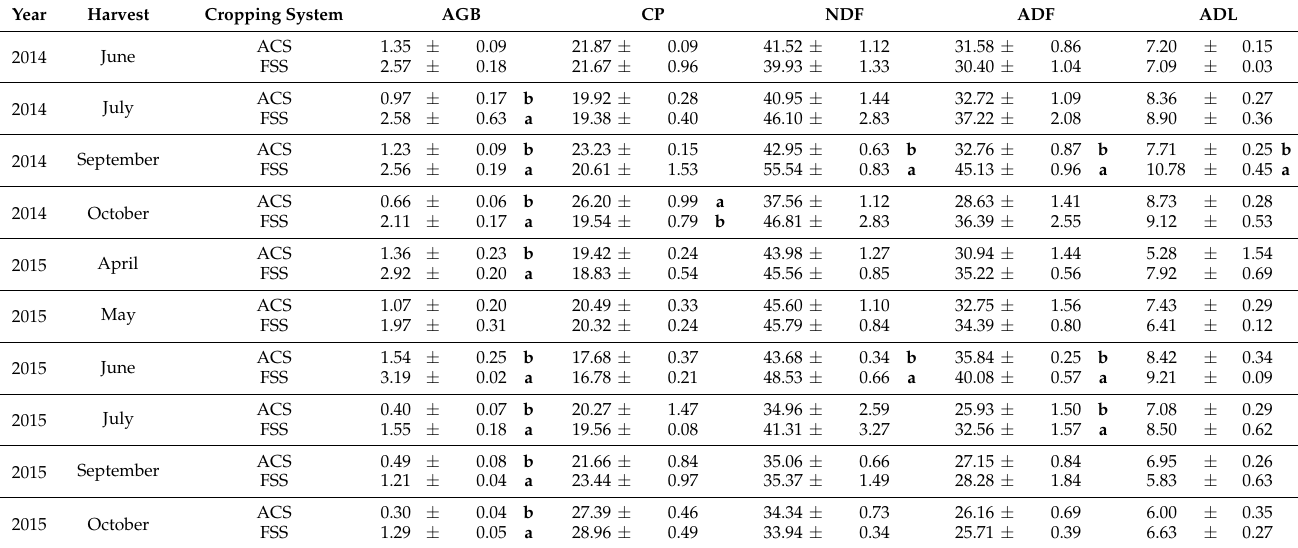
Table 2. Average values and standard error of the alfalfa above-ground biomass production (AGB), the neutral detergent fibre content (NDF), the acid detergent fibre content (ADF), and the acid detergent lignin (ADL) content, in the two cropping systems: alley-cropping (ACS) and full-sun (FSS), and harvest times (from June 2014 to October 2015). Different letters indicate significant differences, p -value < 0.05, based on the two samples Welch’s t -test. Year